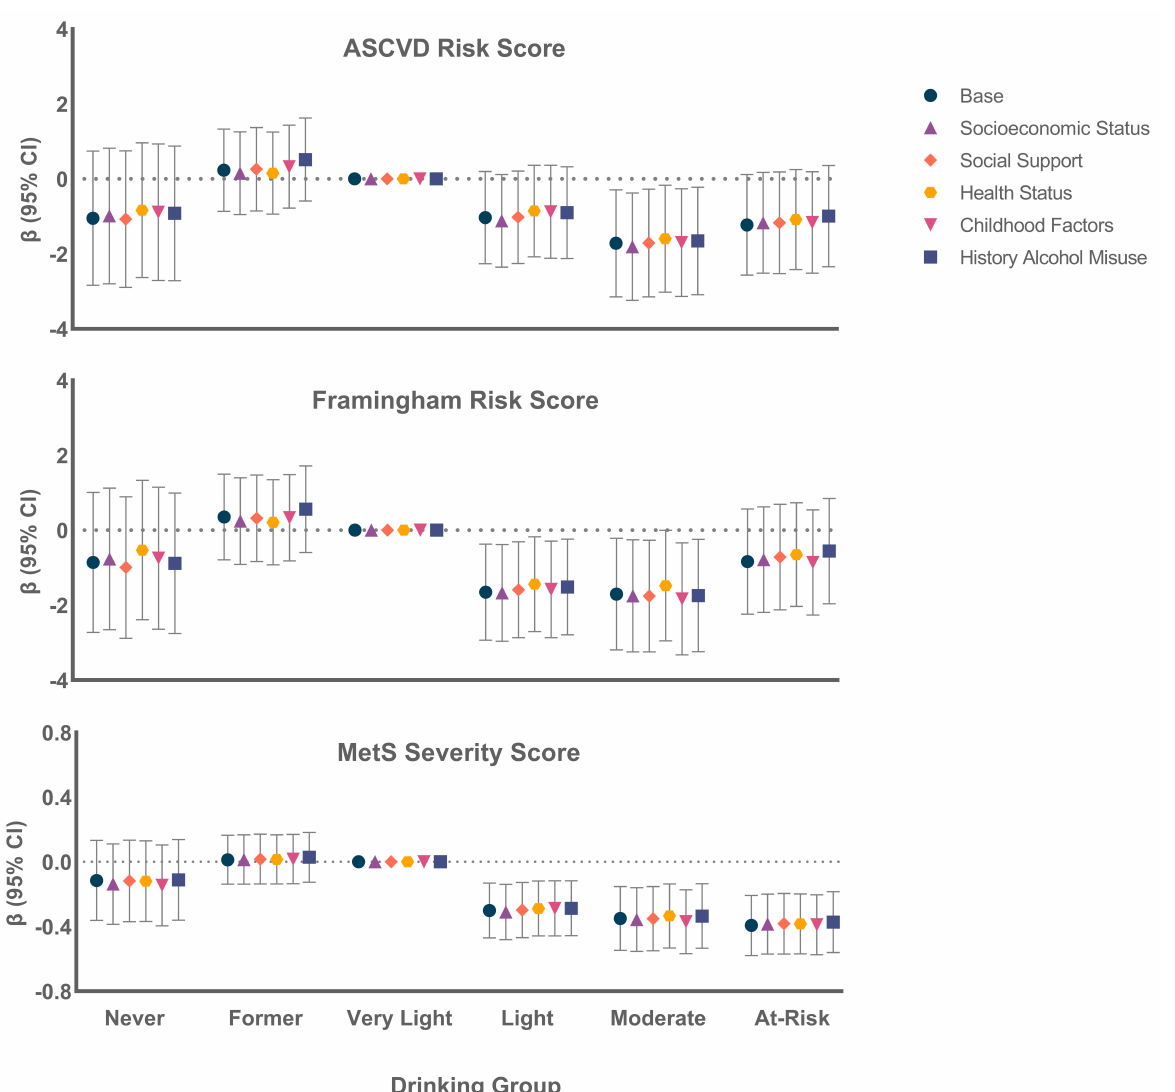
Figure 2. β (95% CI) by drinking group for various explanatory groups, comparing all groups to the very light drinking group, for each of the three CVD risk